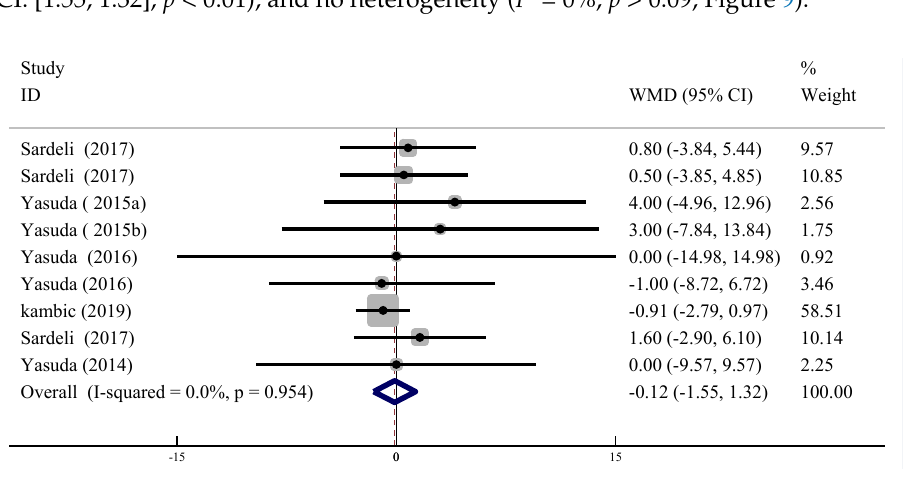
Figure 9. Forest plot of the effect of LL-BFR training on resting DBP.